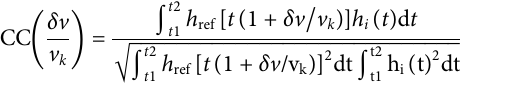
Frontiers in Earth Science |